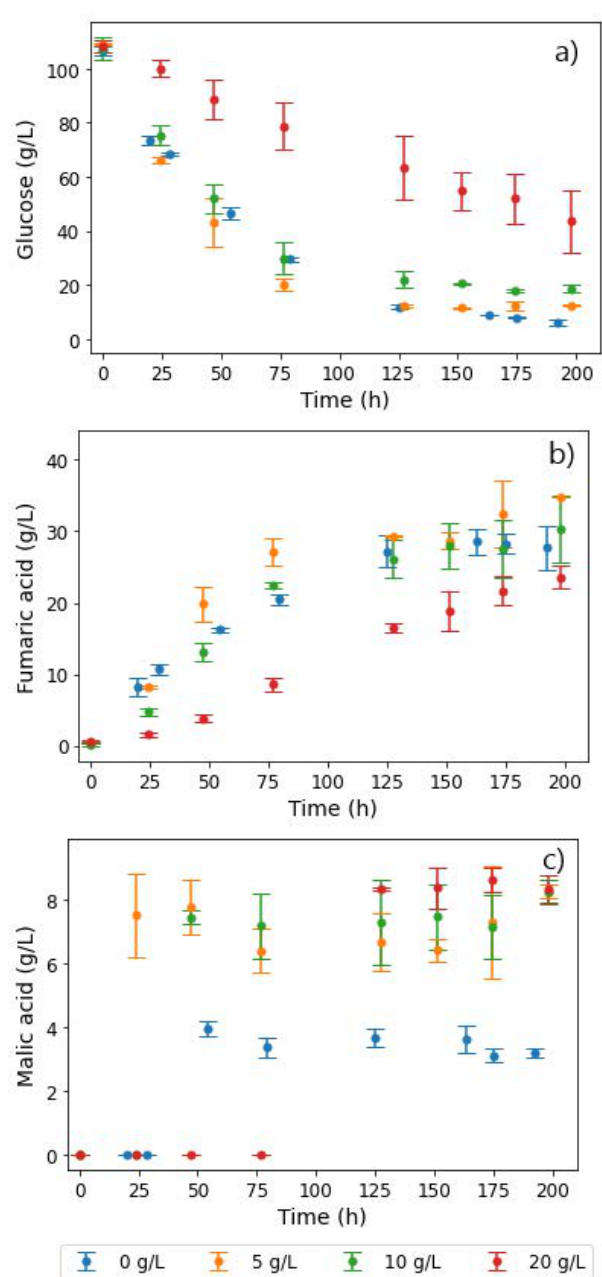
Figure 6. Extracellular concentrations of ( a ) glucose, ( b ) fumaric acid, and ( c ) malic acid during shake flask cultivation of R. delemar with different calcium ion concentrations. Here, 20gL − 1 CaCO 3 was used for pH control as a baseline amount in the experiments and additional amounts of 5, 10, and 20gL − 1 calcium ions were added to the baseline in the form of CaCl 2